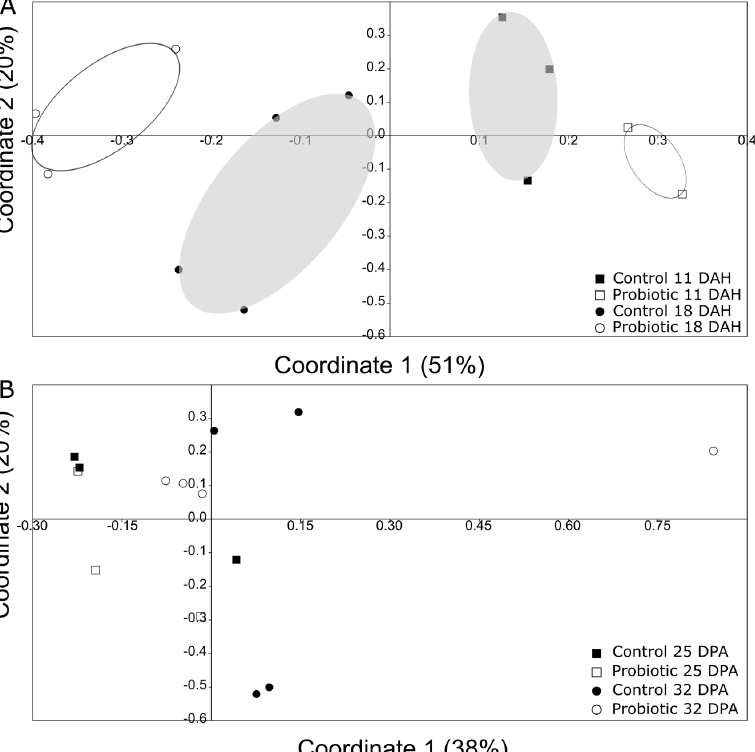
Figure 6. Principal coordinate analysis (PCoA) using Jaccard metric (presence/absence of bands) based on the DGGE information, comparing ( A ) day 11 and 18 in one gel (grey—Control, white—Probiotic), and ( B ) day 25 and 32 in the other gel (grey—Control, white—Probiotic). There was a significant clustering (two-way Permanova, p < 0.05; for more information, look at Table 1) based on both the time point and the treatment between days 11 and 18, but not between days 25 and